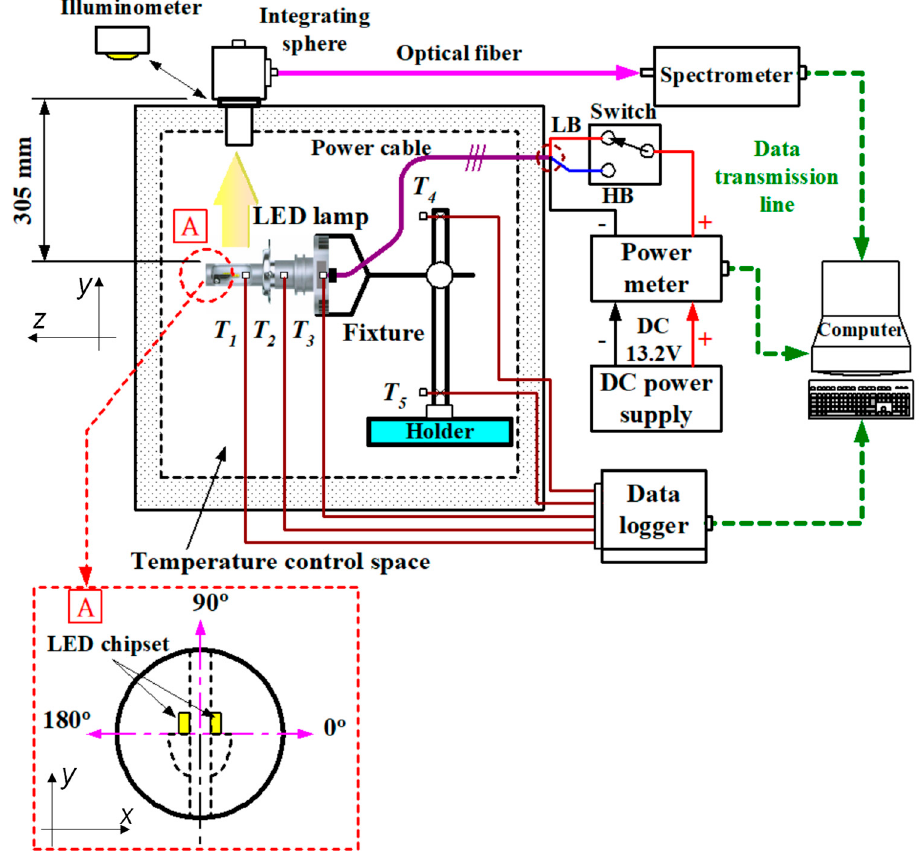
Figure 3. Schematic diagram of the experimental measurement system.